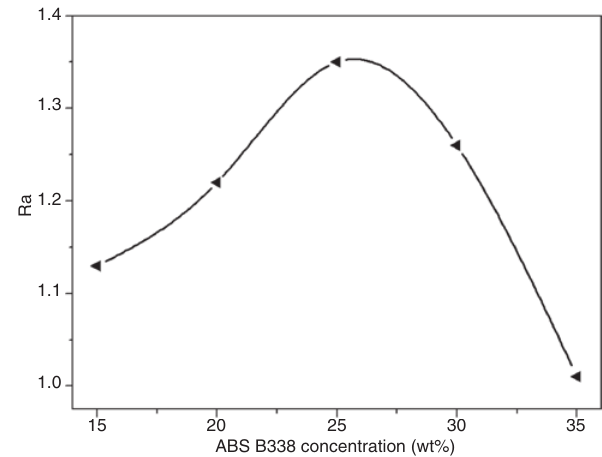
Figure 8 Effect of initiator concentration on Izod impact strength for ABS-g-GMA/St.